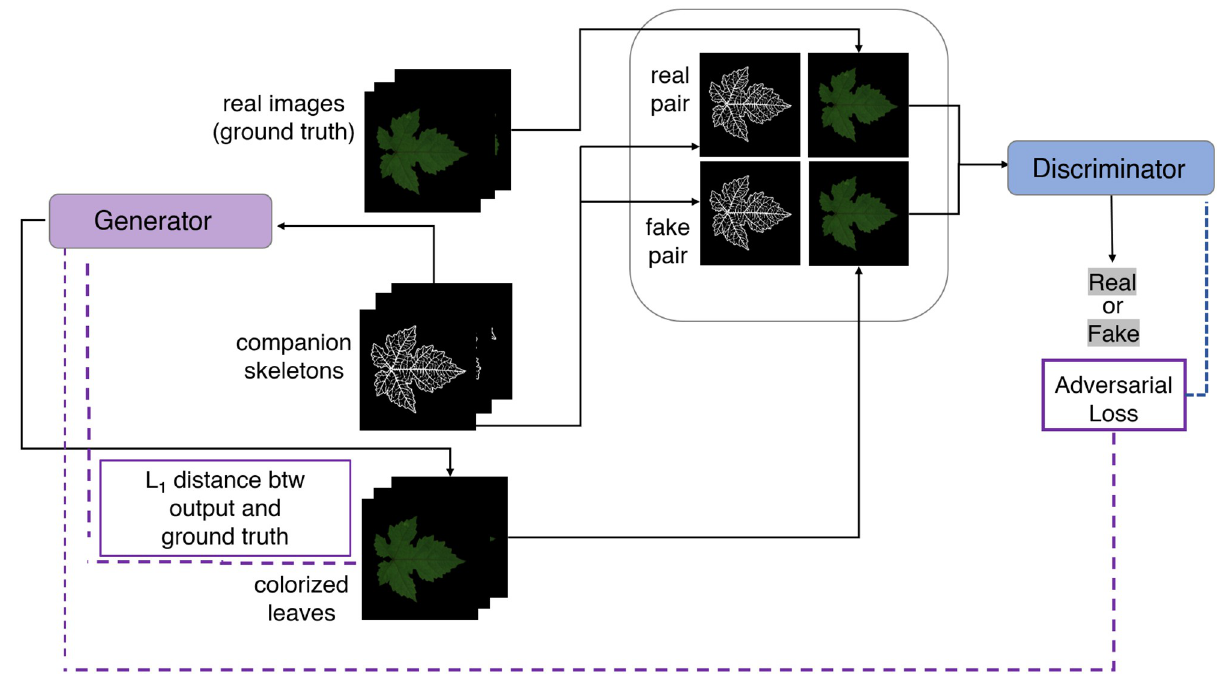
Fig 3. Illustration of the Pix2Pix framework (training).